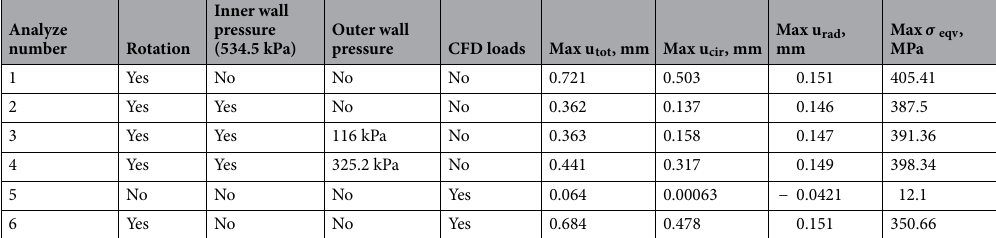
Table 4. Results of the FE analysis.